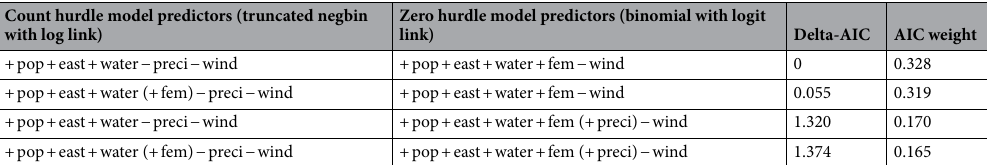
Table 2. Best ranked models according to Akaike’s model weight (cumulative AIC weight > 0.95). Each of the algebraic signs indicates a positive or negative association of predictors (pop = human population, east = binary, region of former political East or West Germany, water = binary, presences of stagnant water bodies, fem = proportion of women, preci = mean precipitation (March to Nov, 2012 to 2017), wind = mean wind speed (1981 to 2000) with submission numbers. In brackets: predictors not present in all of the best